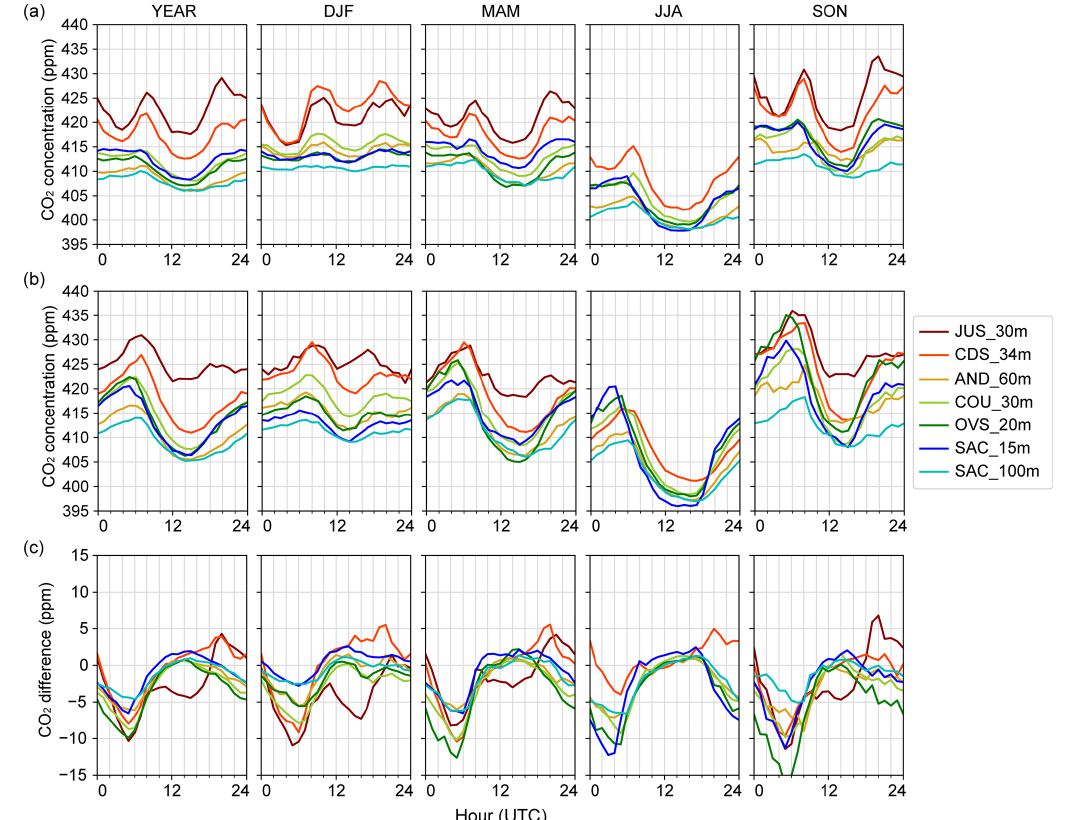
Figure 6. Comparison of average diurnal variations between the (a) BEP_MYJ simulated (control run), (b) observed CO 2 concentrations, and (c) CO 2 differences between the model and the observations for four seasons. DJF denotes December–January–February, MAM denotes March–April–May, JJA denotes June–July–August, and SON denotes September–October–November. The JUS instrument was not working during the summer of